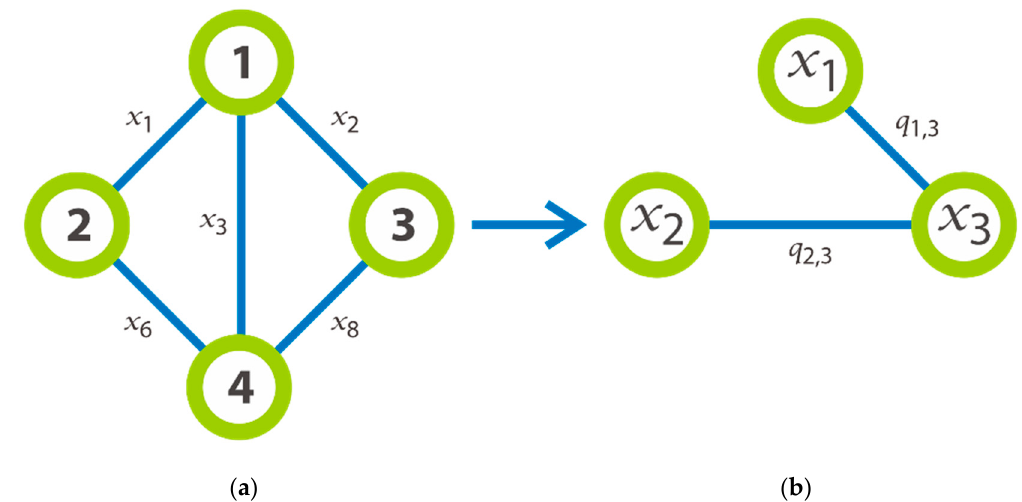
Figure 2. The instance of a graph based on Figure 1 with 4 nodes that transformed into a second reduced graph. ( a ) The existing graph, ( b ) the transformation graph.